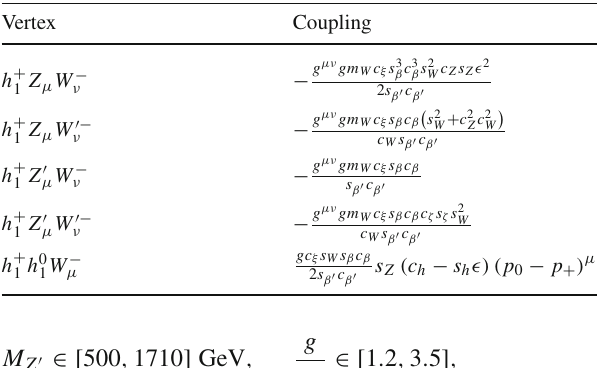
and h 0 are p + 1 1